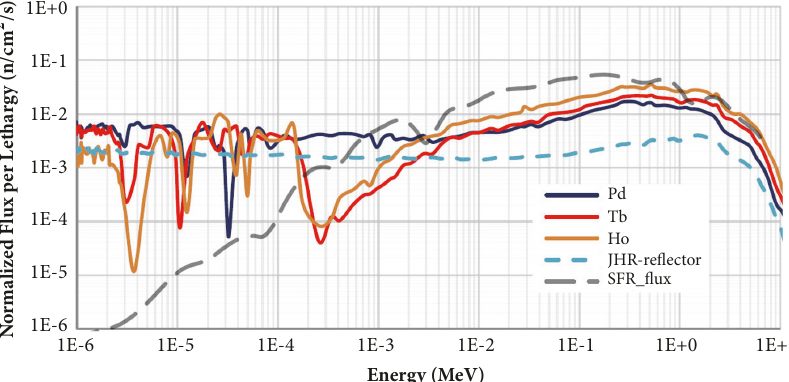
Figure 13: Effect of 3.4 cm Ho, Tb, and Pd neutron screens on the neutron spectrum. The neutron spectrum shifting and broadening are not sufficient. JHR reflector and SFR spectra are included for comparison.